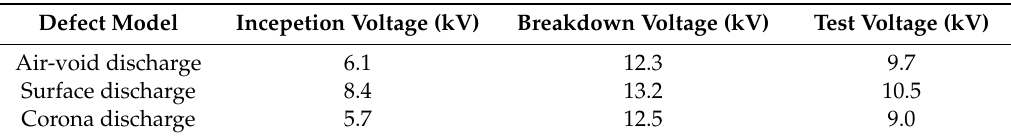
Table 2. Partial discharge (PD) experiment